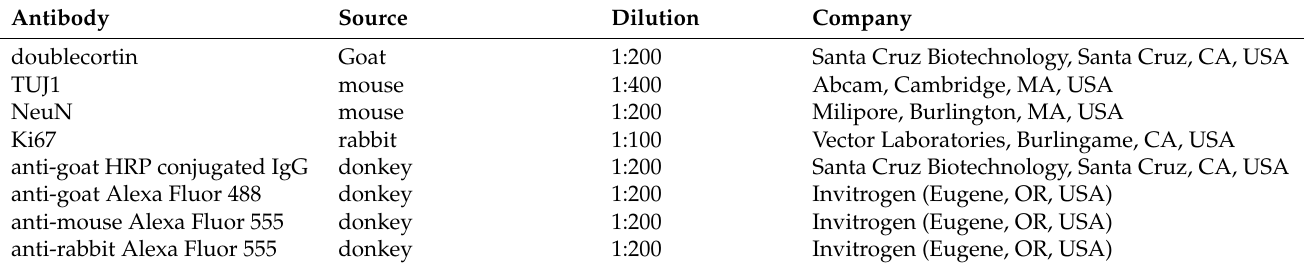
Table 2. The list of the primary and secondary antibodies used for immunohistochemistry and immunofluorescence